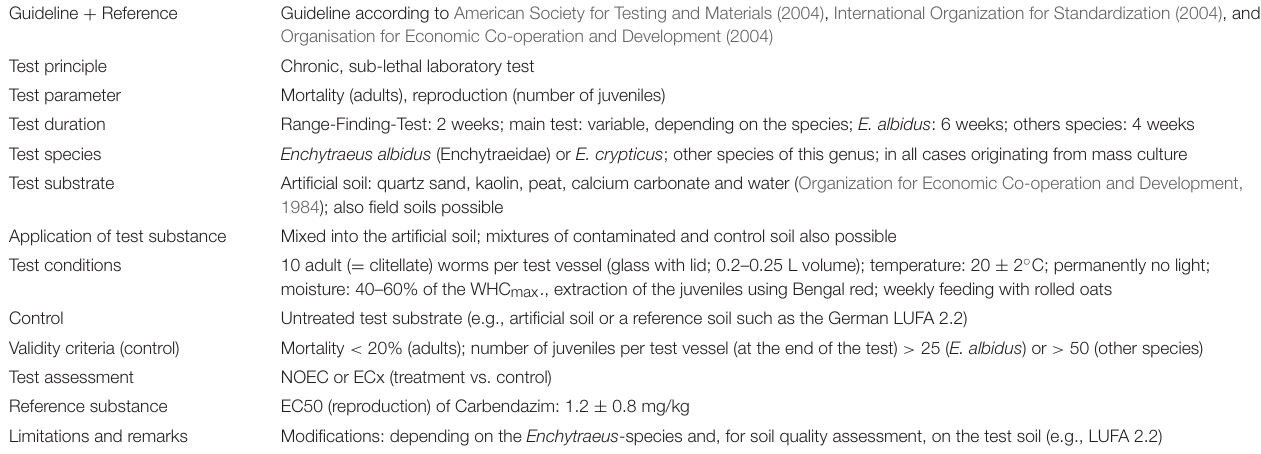
TABLE 2 | Overview of the properties of the Enchytraeid Reproduction Test (ERT), modified from Römbke and Moser (1999) and Römbke (2003). Guideline +